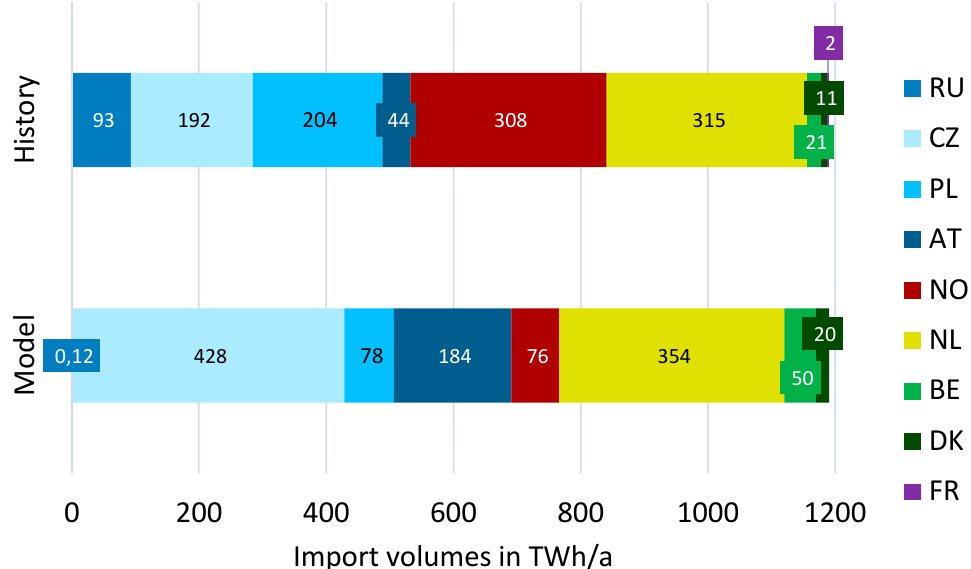
Figure A1. Historical and simulated German gas imports in 2012.